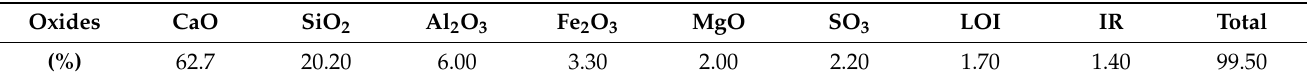
Table 1. Chemical composition of the cement used.